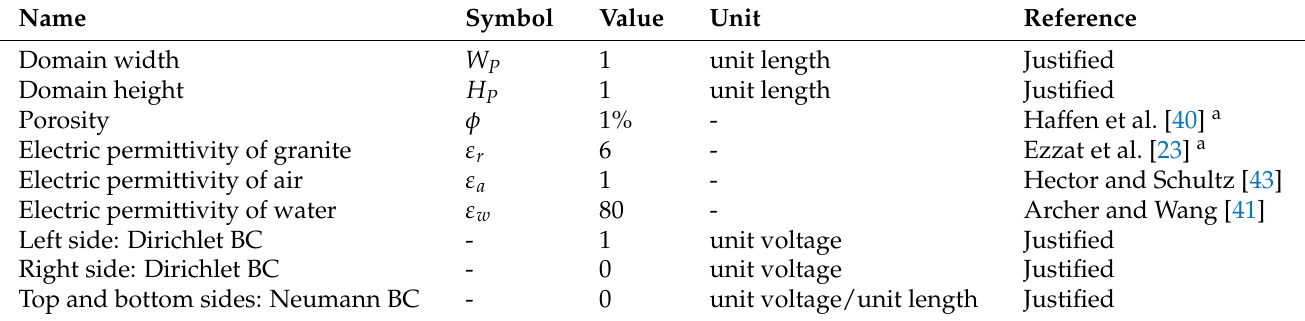
Table 2. The parameters and boundary conditions used in the pore-scale